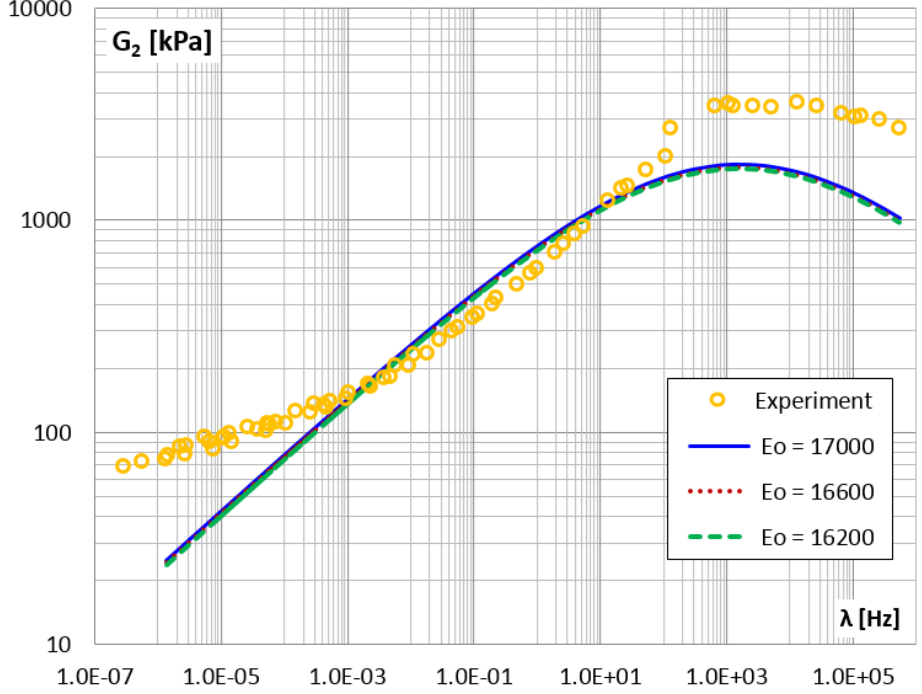
Figure 21. The shear loss modulus G 2 vs. frequency for different values of parameter E 0